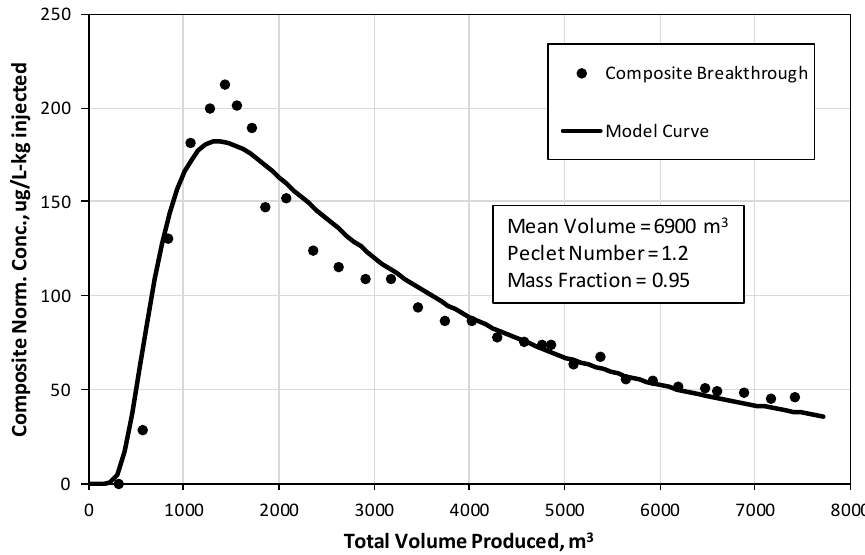
Figure A11. Calculated composite-normalized tracer breakthrough curve for all six well patterns and the results of a RELAP model fit to the data (best-matching parameters listed in box).